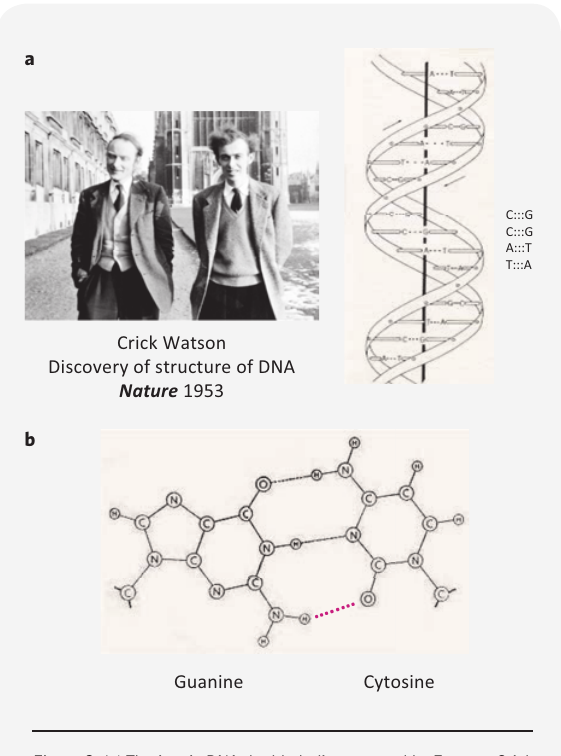
Figure 2. (a) The iconic DNA double helix proposed by Frances Crick and James Watson in 1953, with adenine bound to thymine with two hydrogen bonds and, likewise guanine to cytosine — the third hydrogen bond, explaining specifi city, missing though (b). Figures adapted from illustrations in Ref.